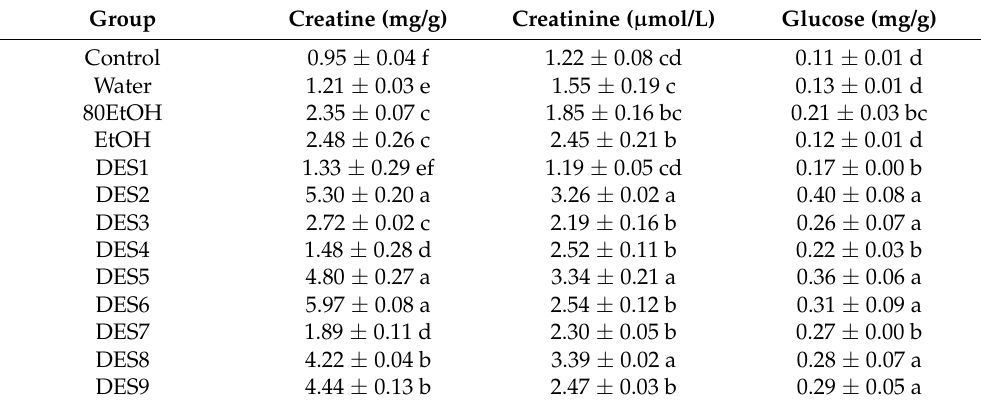
Table 5. Contents of precursors creatine, creatinine, and glucose in beef patties with different ginger